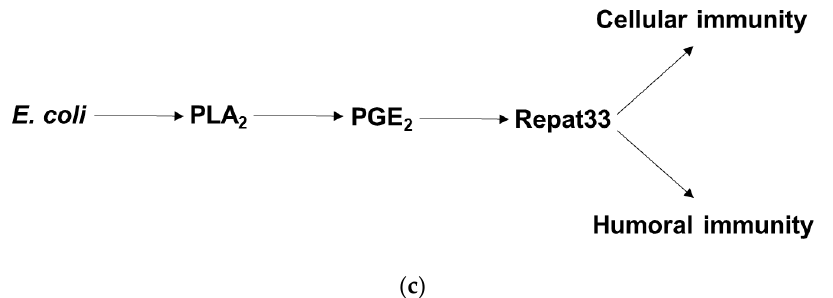
Figure 6. Repat33 as a downstream component of PGE 2 -mediating immune signal in S. exigua . ( a ) PGE 2 -Repat33 signaling in a cellular immune response assessed by hemocyte-spreading behavior. For the immune challenge, E. coli (10 4 cells/larva) was injected into L5 larvae. After 8 h, hemolymph was collected and used for the hemocyte-spreading assay. PGE 2 was injected at a dose of 1 µg/larva. RNA interference (RNAi) of Repat33 expression was performed by injecting dsRNA (‘dsRepat’, 1 μg/larva) specific for Repat33 . At 24 h after injection, larvae were treated with bacteria or PGE 2 . After 8 h, hemolymph was collected and used for the hemocyte-spreading assay. For cytoskeleton analysis, F-actin filaments were specifically recognized by FITC-tagged phalloidin (green). The nucleus was stained with DAPI (blue). Each treatment was independently replicated three times. Scale bar represents 10 µm. ( b ) PGE 2 -Repat33 signaling in humoral immune response assessed by measuring cecropin (‘Cec’) expression levels at 8 h after bacterial challenge. A ribosomal protein gene, RL32 , was used as a reference gene for RT-qPCR. Each treatment was replicated three times with independent biological sample preparations. Different letters indicate significant differences among means at Type I error = 0.05 (LSD test). ( c ) Immune signaling pathway involving PGE 2 and Repat33.